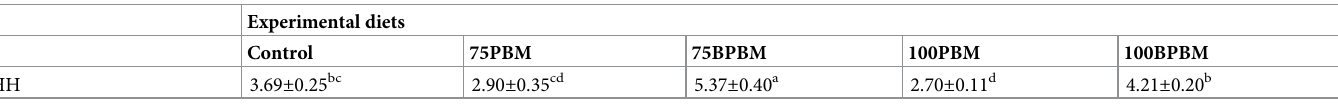
Values are mean ± SE of three replicate fish from each treatment. Values in the same row with different superscript letters (a,b,c) are significantly different based on Tukey’s test (One-way ANOVA, P < 0.05). S SFA = sum of saturated fatty acids; S MUFA, sum of monounsaturated fatty acids; S PUFA, sum of polyunsaturated fatty